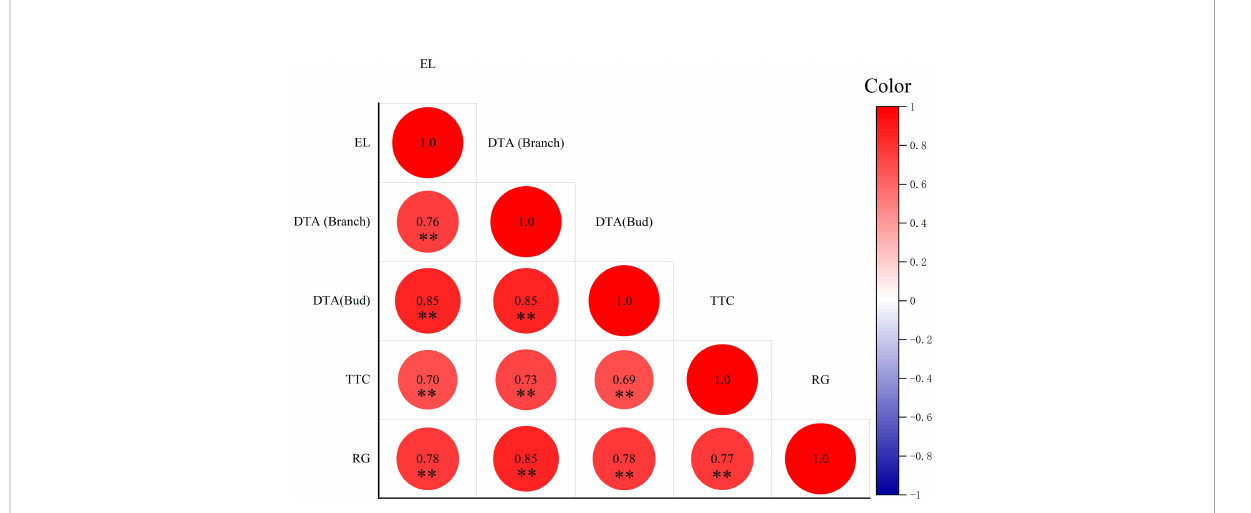
FIGURE 2 Correlation of LT 50 values estimated by different methods. Data were tested by Student ’ s t-test, ** p < 0.01 represent signi fi cant differences between methods. The larger the circle, the larger the correlation coef fi cient. Red is positive, blue is negative.